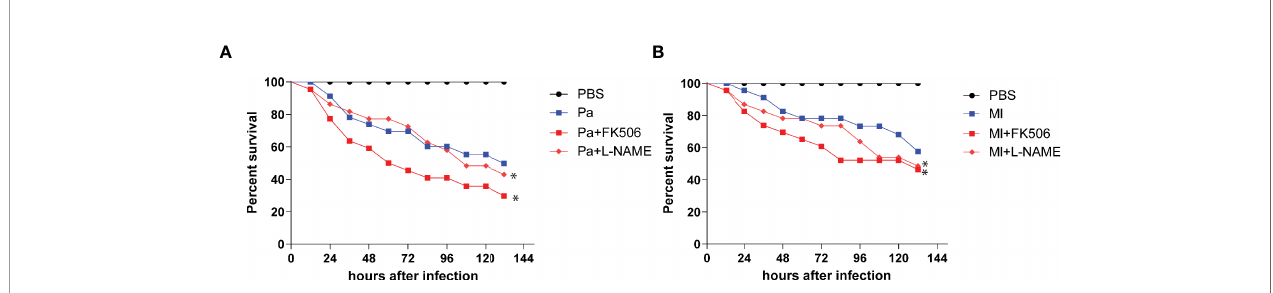
FIGURE 1 | Inhibition of CanA and NOS caused more deaths of infected O. furnacalis larvae. After elimination of indigenous bacteria using 50 m g/ m L tetracycline, day 3, 4 th instar larvae were injected with 1× 10 4 cells of P. aeruginosa (A) or M. luteus (B) cells or along with 2 nmol FK506 or L-NAME, using PBS as control. All the data was analyzed using the log-rank test. *, p < 0.05; FK506, CanA inhibitor; L-NAME, NOS inhibitor; Pa, P. aeruginosa ; Ml, M. luteus